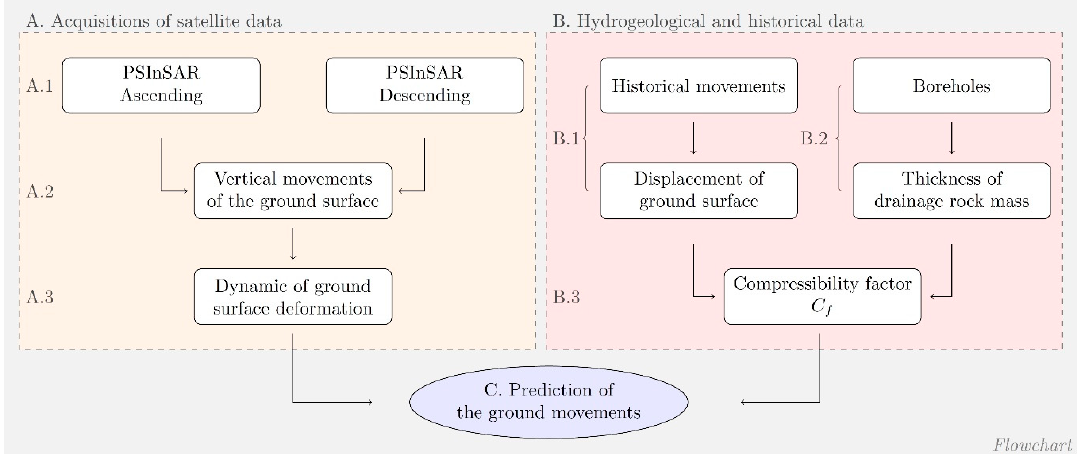
Figure 3. Scheme of the methodology Figure 3 . Scheme of the methodology chain.